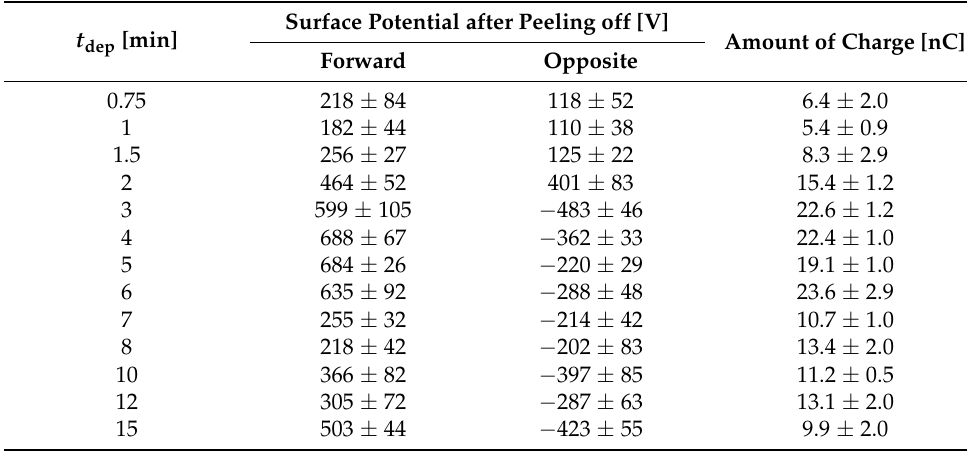
Table 3. Surface potentials of the fiber mats produced with different t dep in V ES = 11.0 kV after peeling them from each ITO/glass substrate and placing them in the forward and opposite arrange- ments. Here, the errors represent the standard deviations from four samples produced under the same conditions. Surface Potential after Peeling off [V] Amount of Charge [nC]